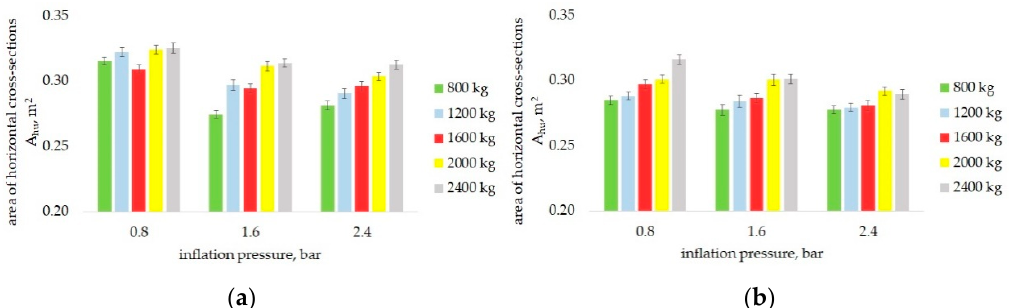
load: radial tire ( a ); bias-ply tire ( b ). radial tire ( a ); bias-ply tire ( b ).